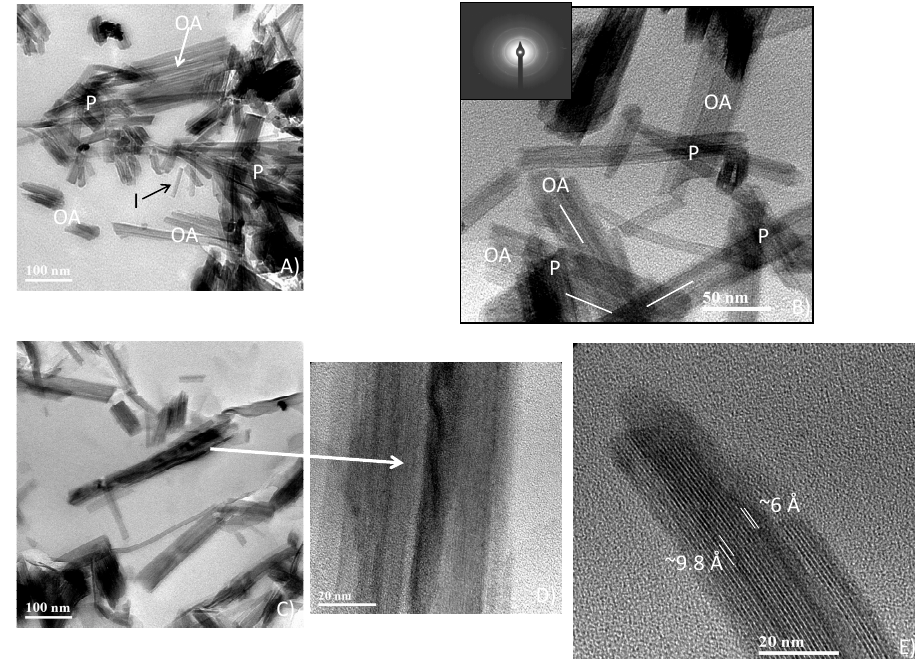
Figure 4. High–resolution transmission electron micrographs (HRTEM) of nanocrystalline todorokite: ( A , B ) (I) Isolated primary elongated striated particles of acicular todorokite; (OA): acicular particles elongated up to 200 nm, which are laterally aggregating together, forming stable laths up to 100 nm wide; ( p ): plate-like morphology, with plates comprised of overlapping todorokite laths—note trilling intergrowths where individual laths are oriented specifically in three distinct directions at 60°/120° (white lines in Figure 4B) to each other to form large aggregates with a plate-like morphology. The selected area electron diffraction (SAED) pattern in b shows diffraction rings at 2.4 Å. ( C , D ) laterally aggregated todorokite laths comprised of aligned overlapping elongated nanoparticles, also showing in the enlarged area structural defects in the form of spiral-like longitudinal dislocations; ( E ) todorokite showing lattice fringes at a spacing of approximately 9.8 Å; note tunnel-width inconsistencies (heterogeneous tunnel dimensions) observed as additional ~6 Å spacings in the a direction.